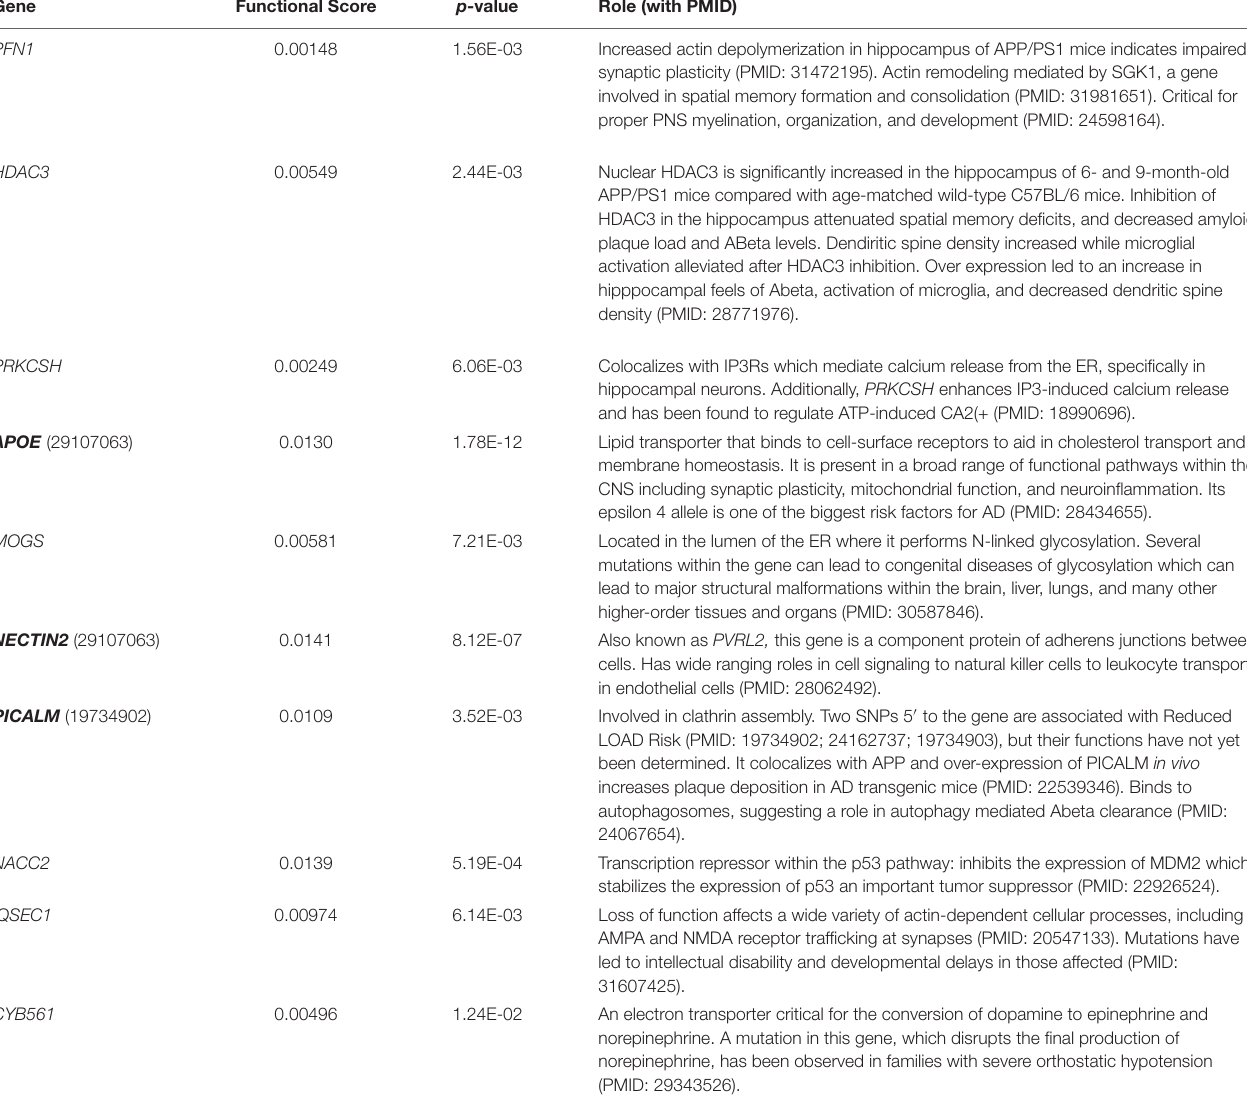
TABLE 1 | Brief descriptions of the top genes according to the combined score for the hippocampus.